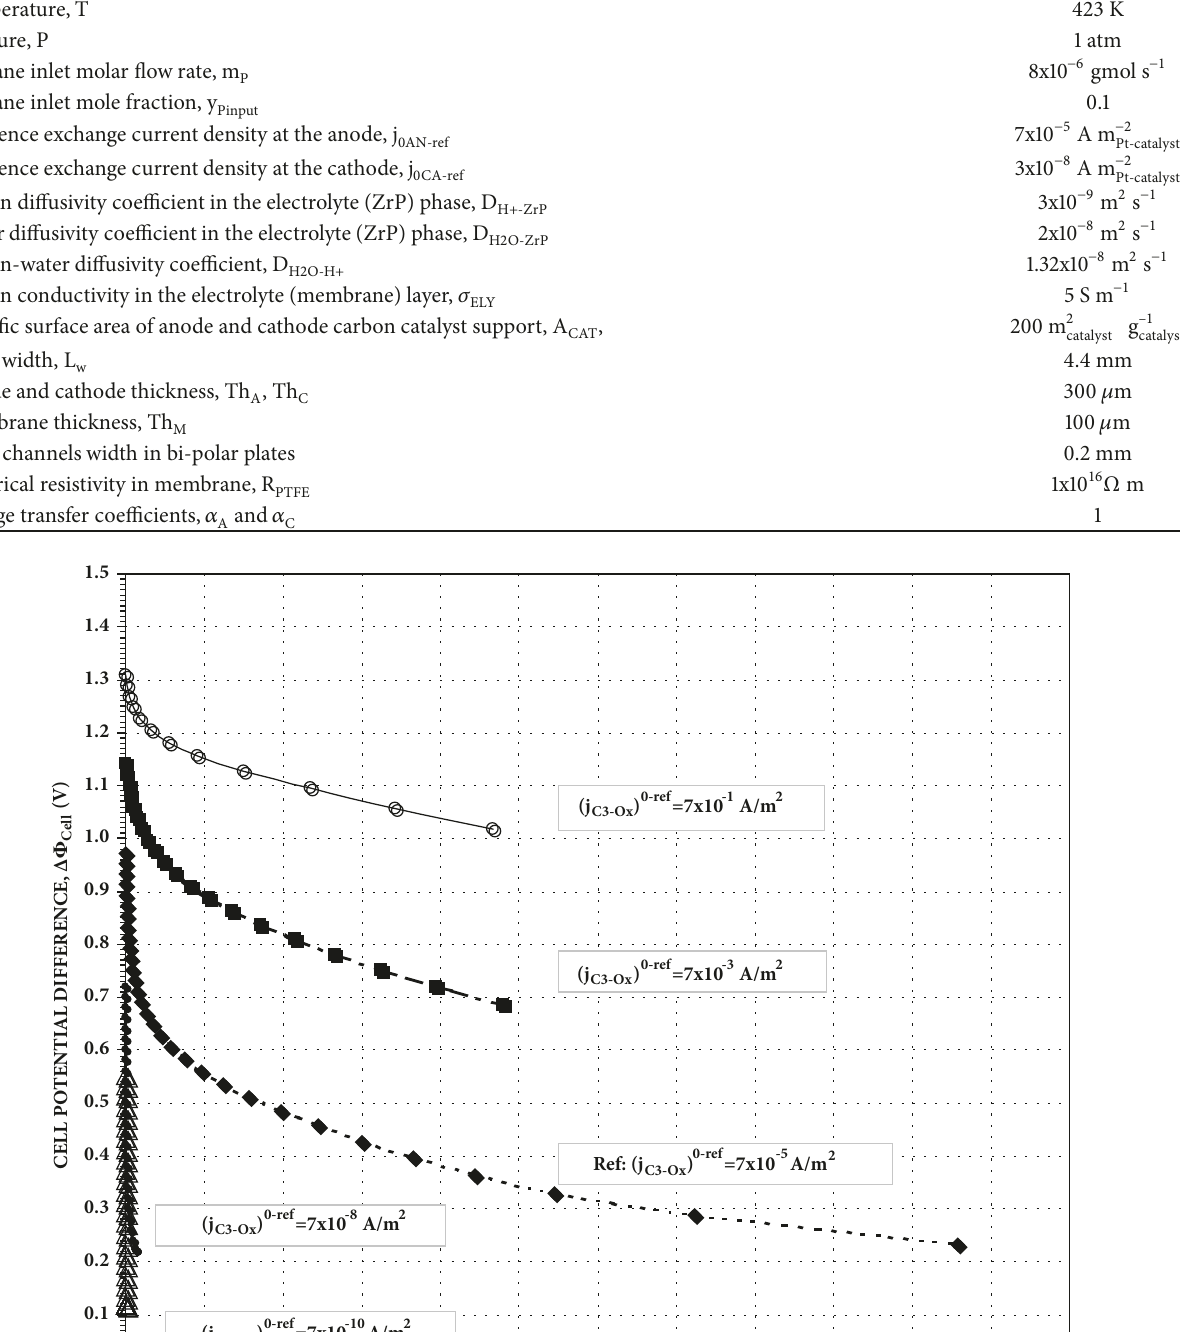
8x10 −6 gmol s −1 0.1 7x10 −5 A m −2 Pt - catalyst 3x10 −8 A m −2 Pt - catalyst